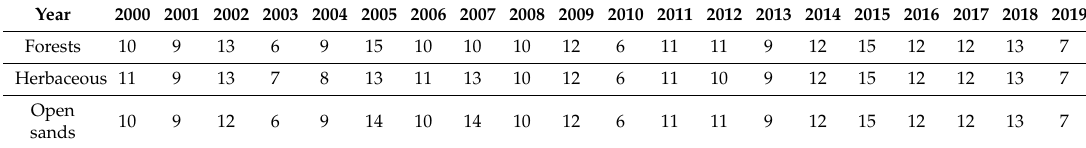
Table 2. Number of available satellite images per year, used for